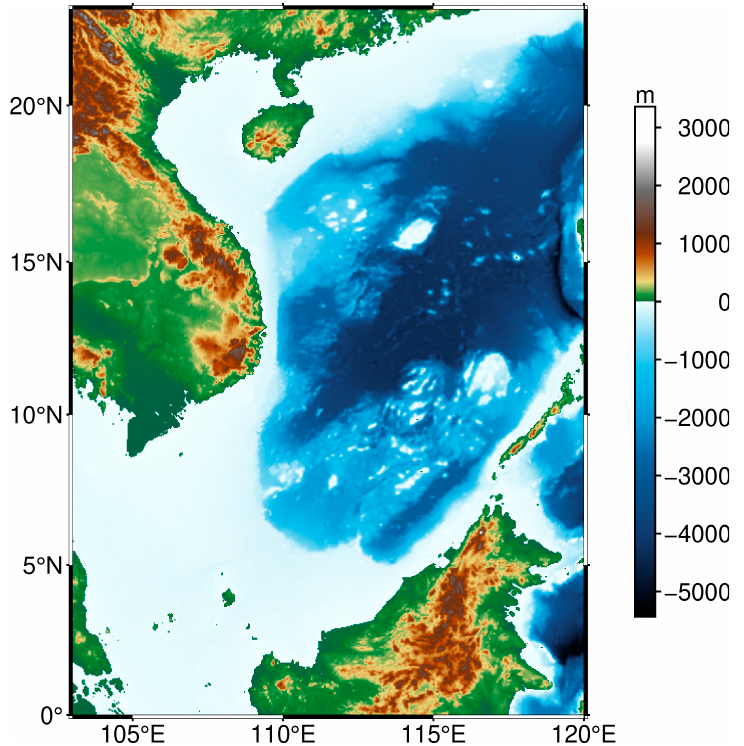
Figure 1. Topographic map of the South China Sea.